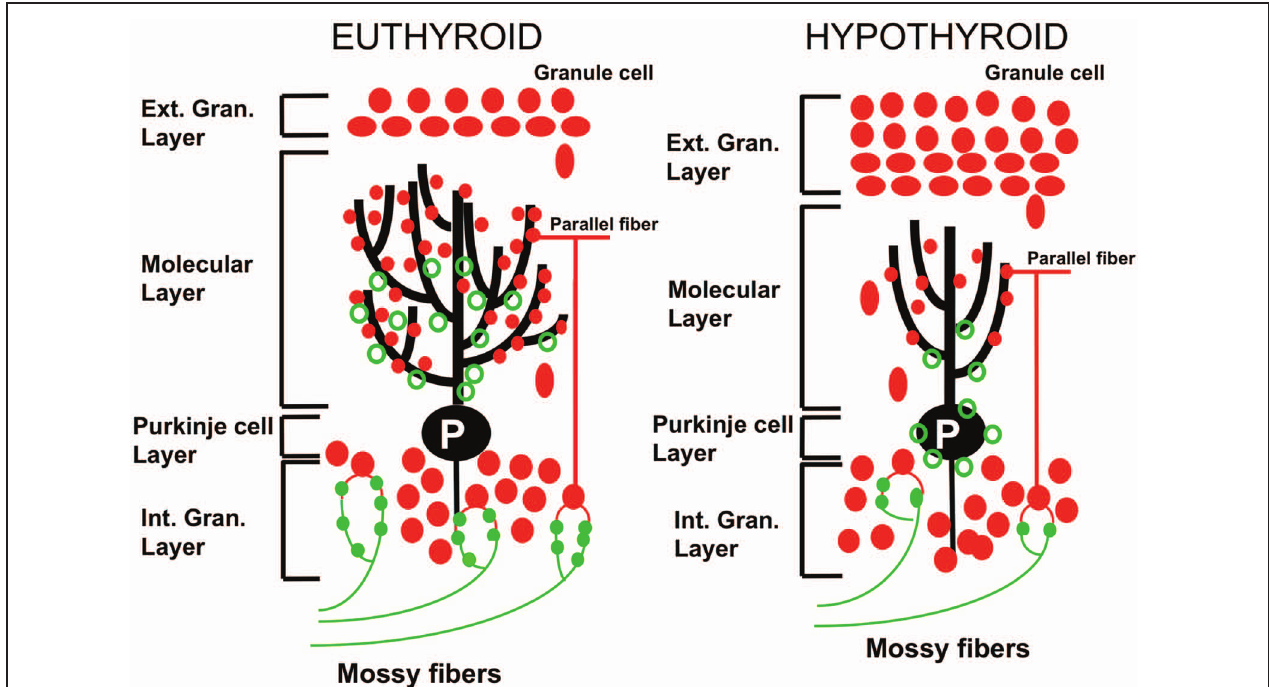
FIGURE 1 | Effect of perinatal hypothyroidism on neurogenesis and differentiation of the cerebellar cortex. In the hypothyroid cerebellum (right panel), disappearance of the external granular layer is delayed consequently to the retarded proliferation and migration of granule cells to the internal granular cell layer. The arborisation of the dendrites of Purkinje neurons (P) is